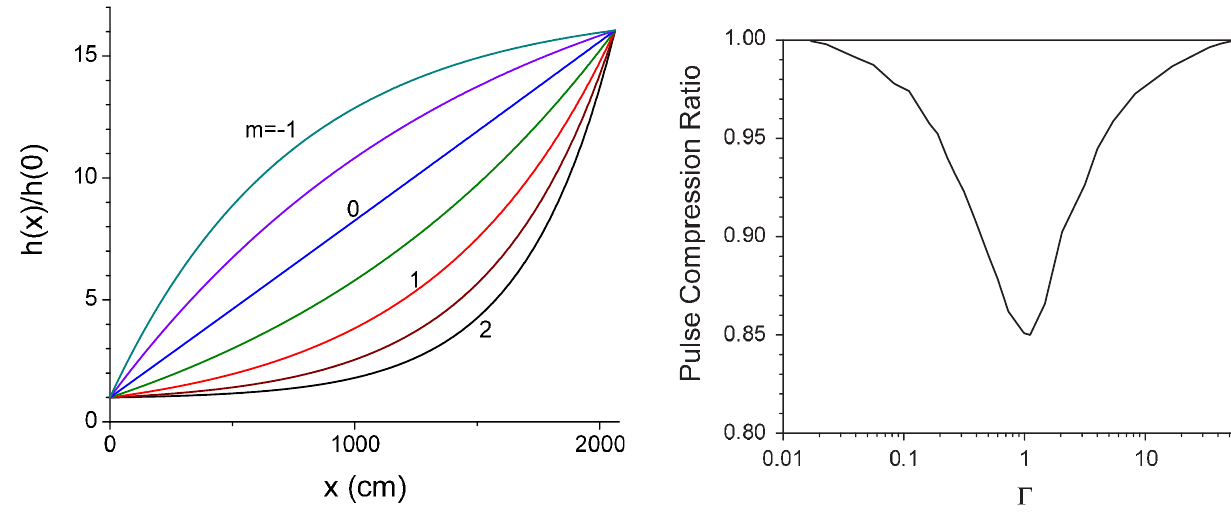
FIG. 8. The ratio of the output to input voltage pulse width for the exponential impedance profile as a function of the normal- ized pulse width (cid:1) .